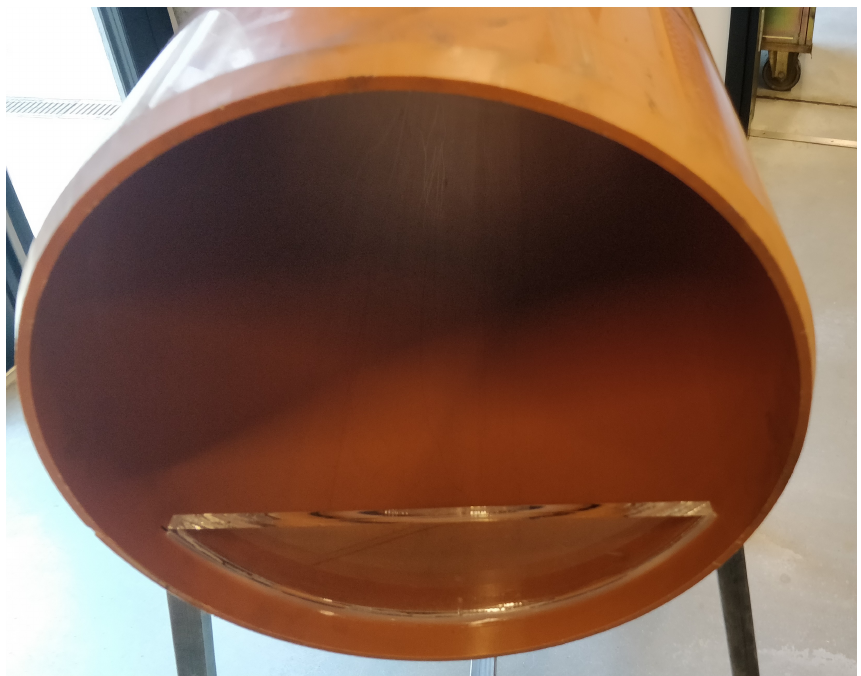
Figure 8. Water level setup. A piece of acrylic glass is inserted at both ends of the pipe in order to accommodate